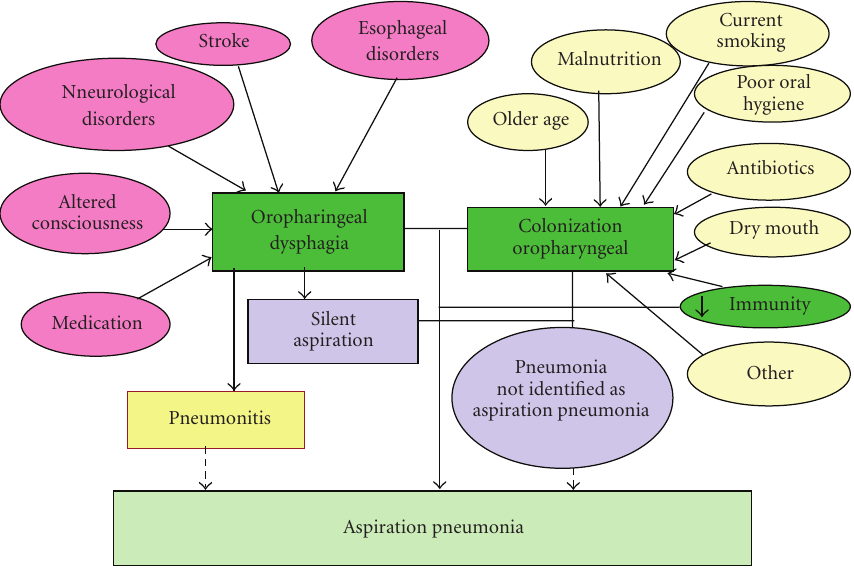
Figure 7: Risk factors for oropharyngeal colonization by respiratory pathogens and aspiration pneumonia in older people.